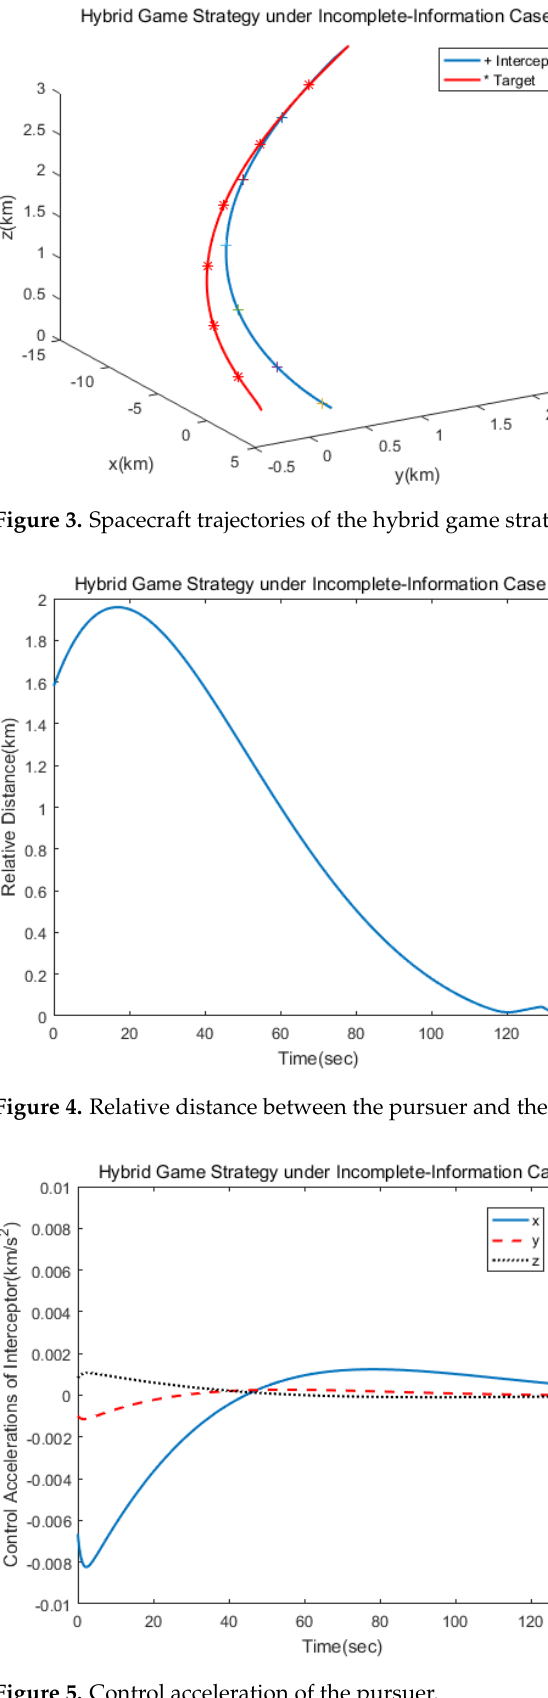
Figure 5. Control acceleration of the pursuer.